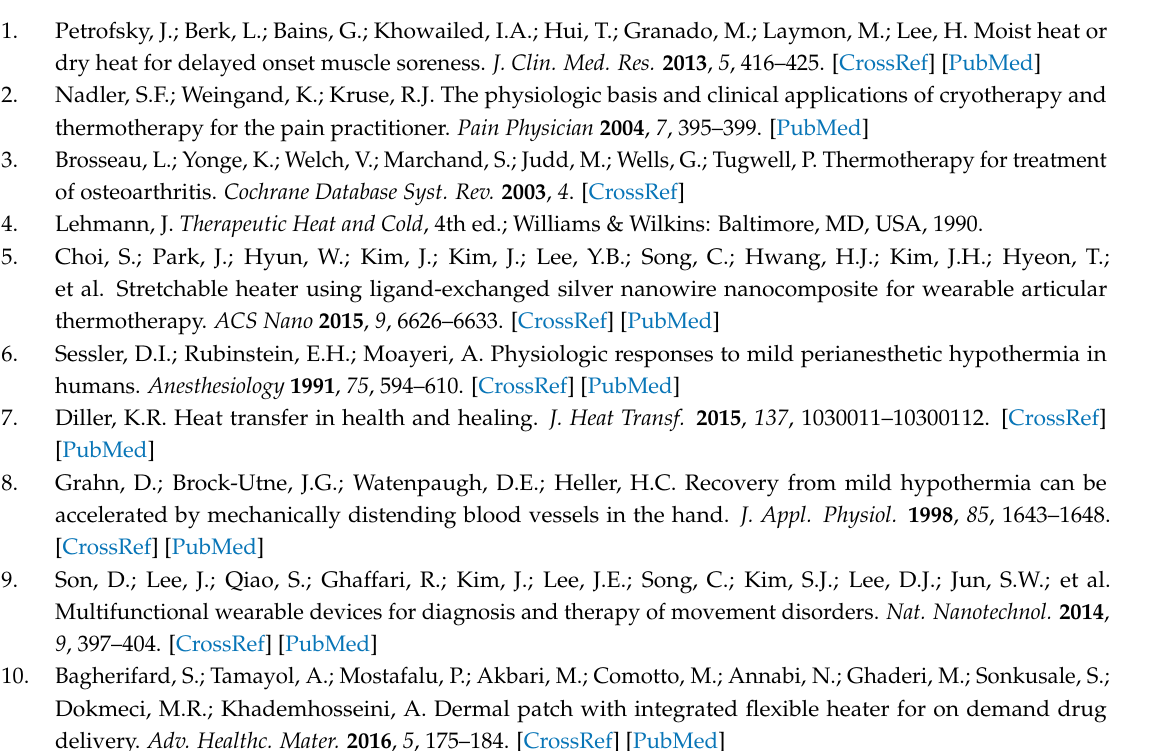
Figure S1: Snap button connections, Figure S2: RTD calibrated on hotplate, Figure S3: RTD calibrated on glass with RHE, Figure S4: Error from set point during extended palm heating with device with PID control. Figure S5: Stretchability test, Figure S6: Effect of skin deformation, Table S1: Steady state temperatures for different voltages and temperature to voltage ratios, Video S1: Hand Clench